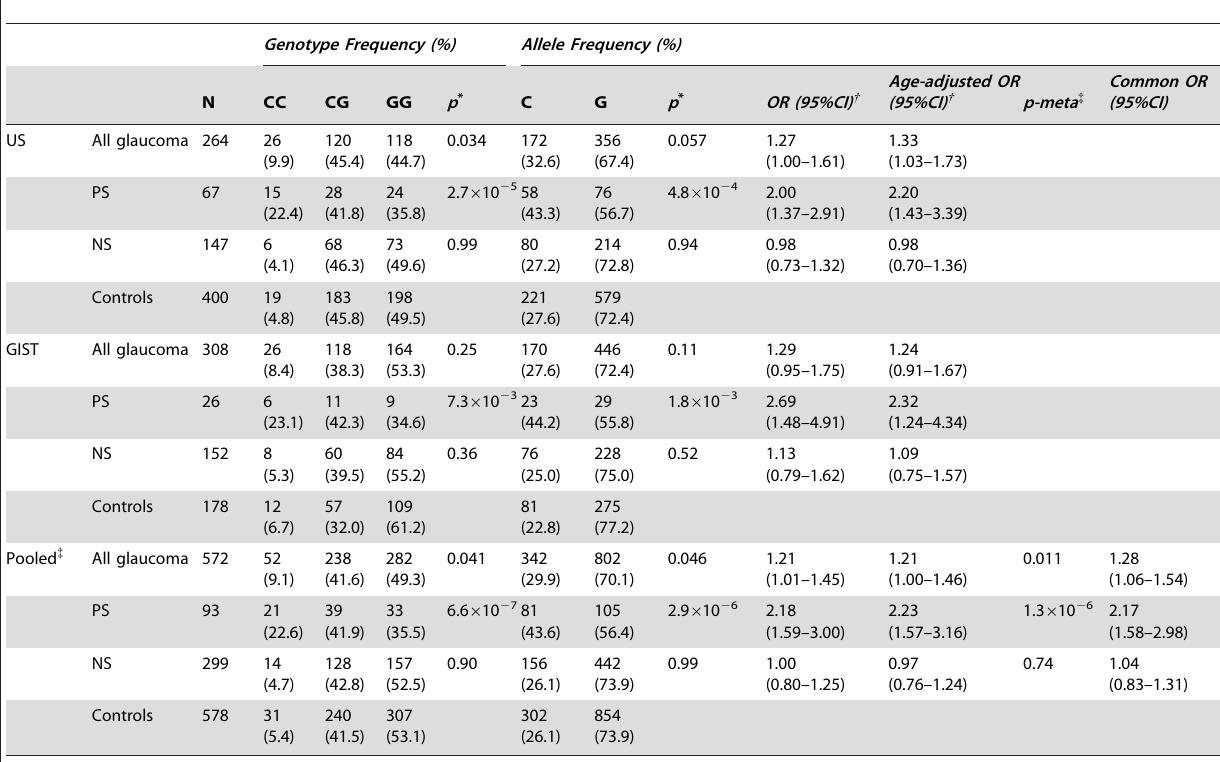
Table 3. Association of p53 codon 72 variants with paracentral scotomas (PS) in the US and GIST cohorts.